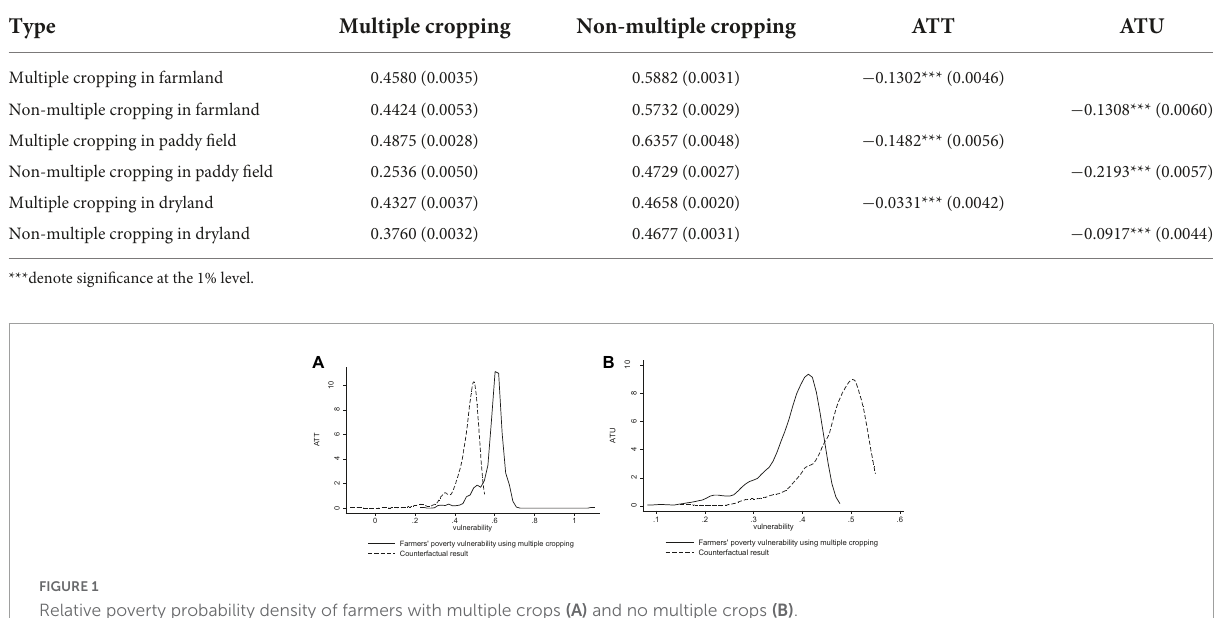
the scenarios of multiple cropping of farmland or not. Figure 1A shows that, in the counterfactual case, the probability density distribution curve of relative poverty shifts to the right if the households adopting multiple cropping of farmland do not adopt it, indicating that the sample selection bias is solved, the multiple cropping of farmland will significantly reduce the households’ relative poverty (ATT = − 0.1302). As shown in Figure 1B , in the counterfactual case, if farmers who do not adopt multiple cropping of farmland adopted it, the probability density distribution curve of their relative poverty would shift to the left, indicating that the relative poverty of farmers without multiple cropping of farmland would be reduced after the adoption of multiple cropping (ATT = − 0.1308). Due to the limitation of space, the probability density map of relative poverty of farmers’ multiple cropping in paddy field samples and dryland samples was not